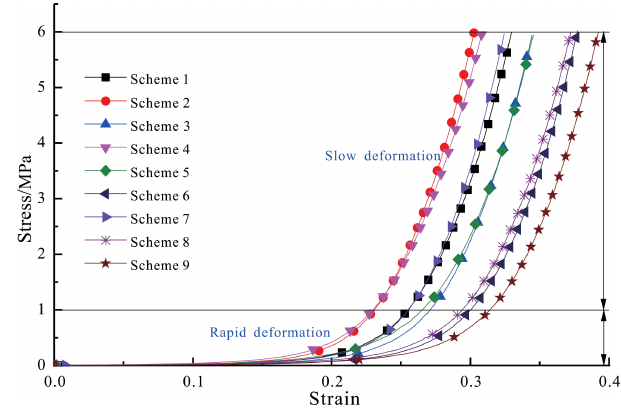
Figure 5. Stress–strain curves of backfill